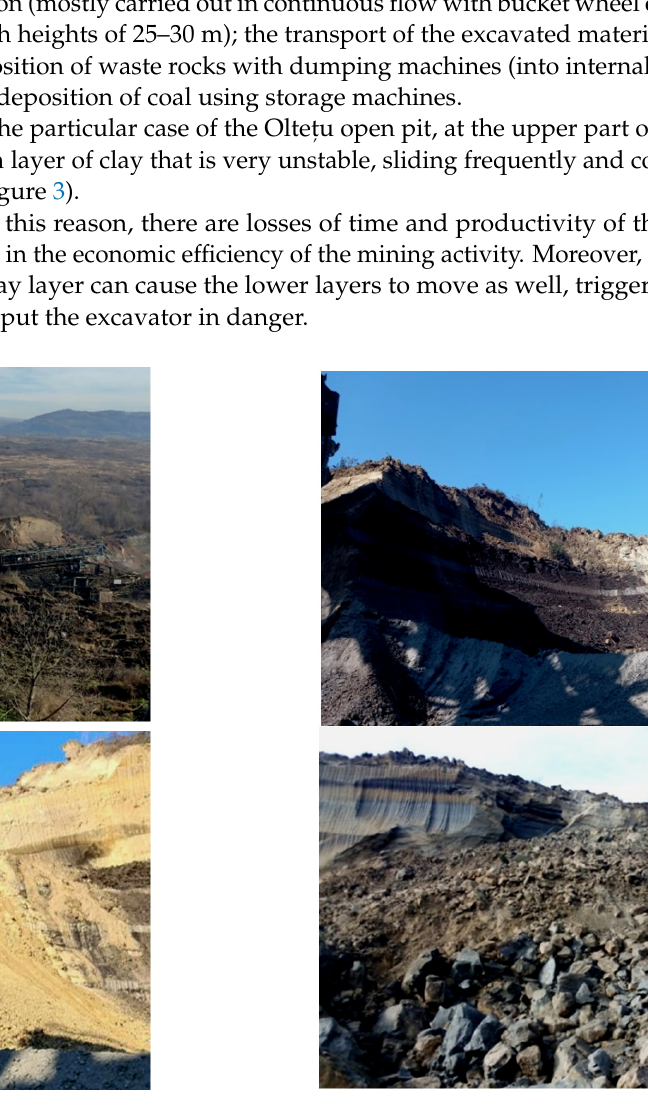
Figure 3. Intense fragmentation and (dry) flows of the clay upper layer.